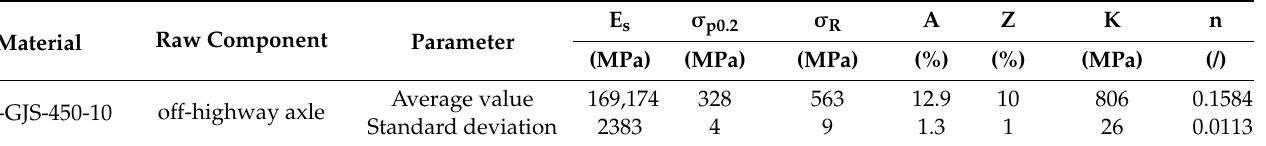
Table 5. Static tensile properties of EN-GJS-450-10. Average values and standard